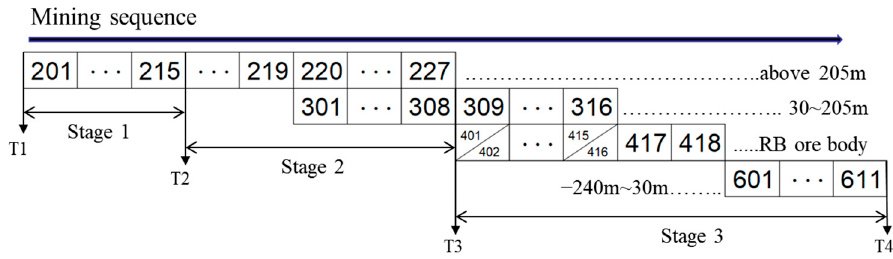
Figure 10. Stopes distribution and mining sequence in the same level ( a ) Stopes distribution above